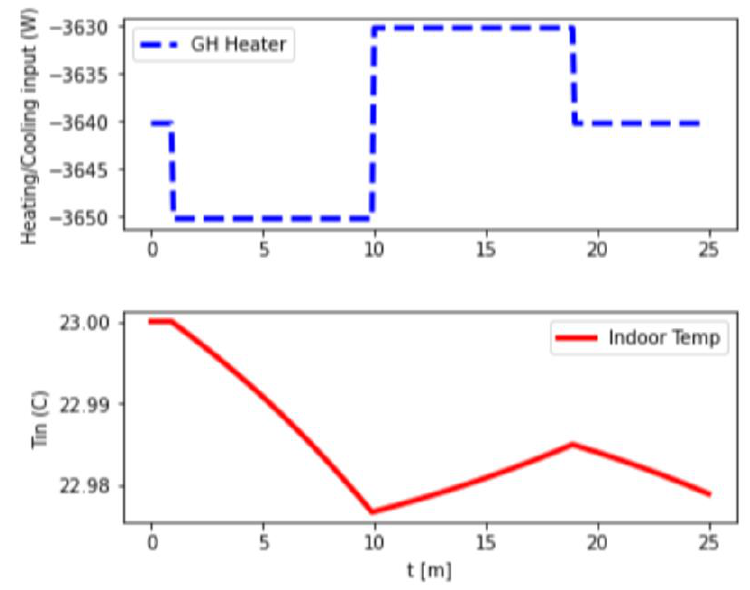
Figure 8. Simulated process response to Doublet test.